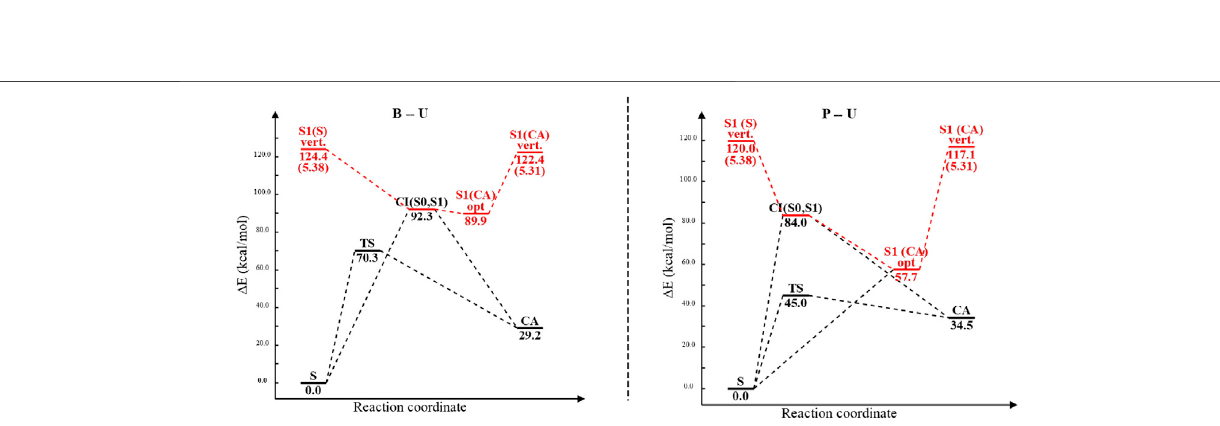
binding energy are − 8.89 kcal/mol.